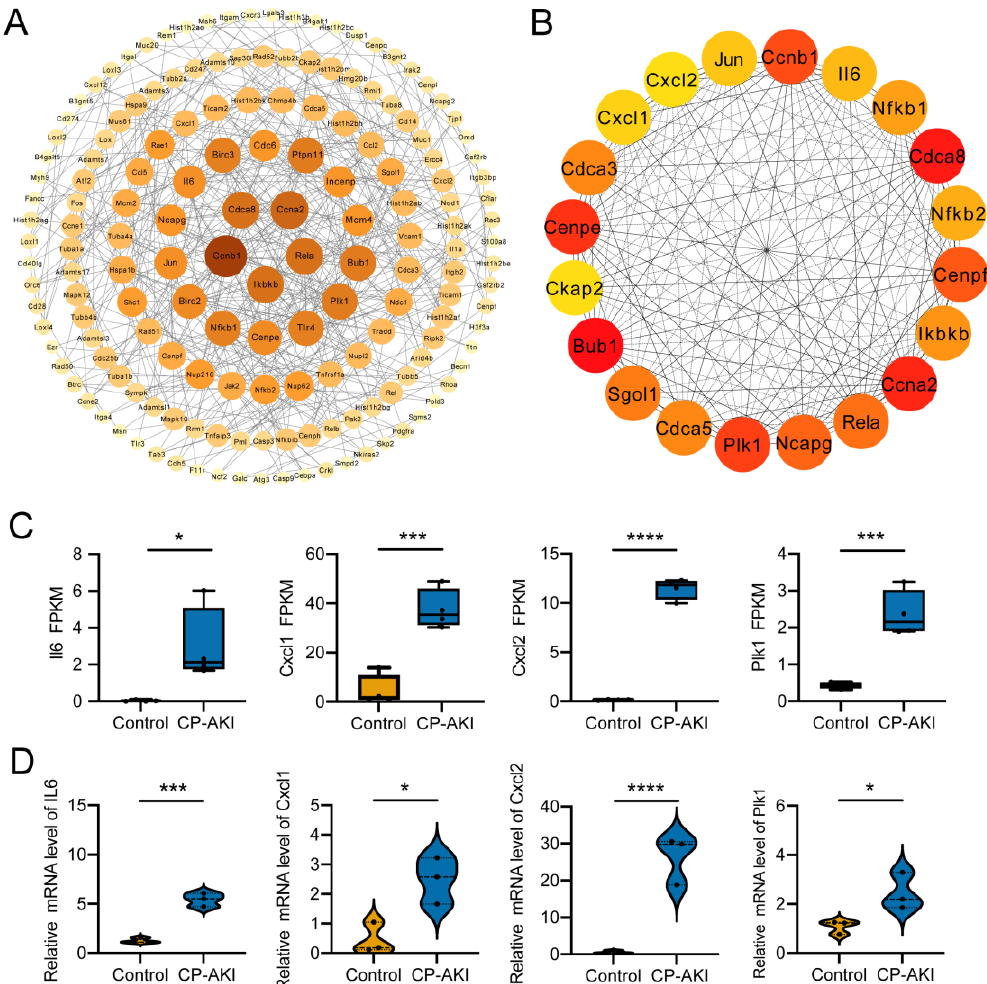
Figure 5. Construction and validation of the protein‒protein interaction (PPI) network. ( A ) The PPI network of upregulated mRNAs in CP-AKI versus control mice. ( B ) Top 20 hub genes from PPI networks. ( C ) Relative expression (FPKM) levels of Il6 , Cxcl1 , Cxcl2 , and Plk1 in control and CP-AKI mouse kidneys according to RNA-seq ( n = 4). ( D ) Validation of Il6 , Cxcl1 , Cxcl2 , and Plk1 expression levels by RT-qPCR between the two groups ( n = 3, respectively). * p < 0.05, *** p < 0.001, **** p < 0.0001.